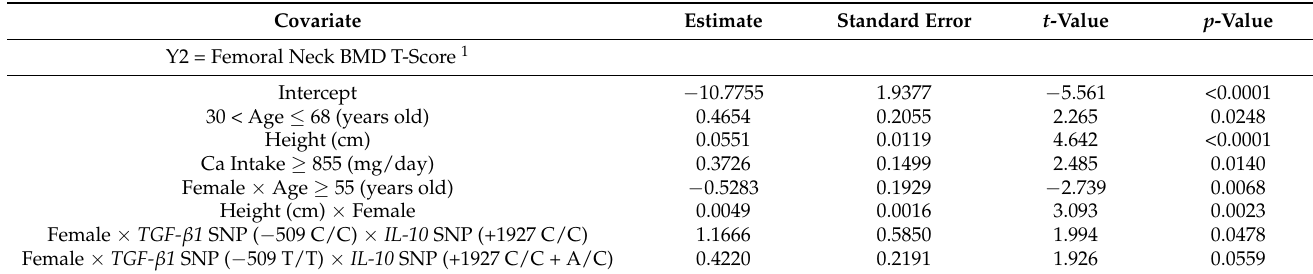
Table 4. Multivariate analyses of the predictors of femoral neck BMD T-scores using MLR models.